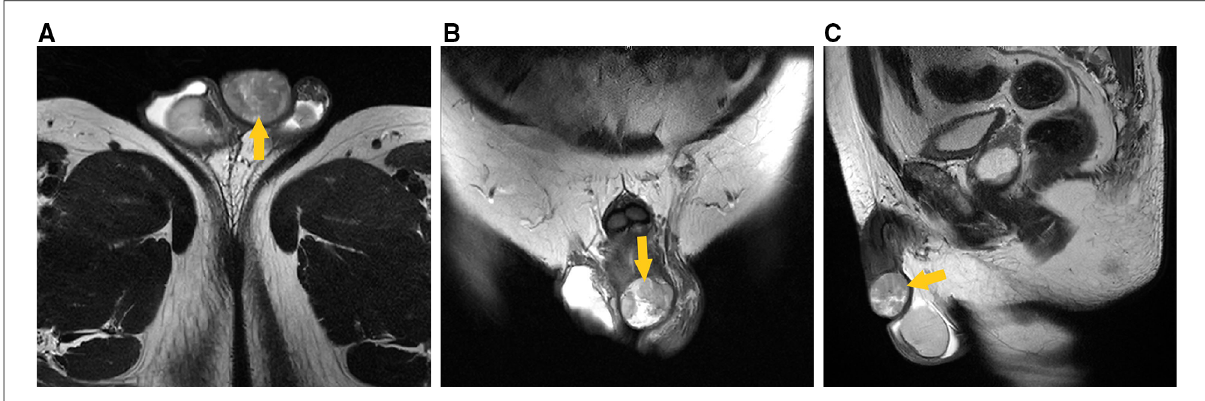
FIGURE 1 Preoperative pelvic MRI (male genital system) showed nodular mixed signal shadow in the distal penis (arrow head), with a size of about 31 mm× 27 mm×22 mm, and a high signal on DWI. ( A ) Transverse section, T2-weighted imaging. ( B ) Coronal section, T2-weighted imaging. ( C ) Median sagittal section, T2-weighted